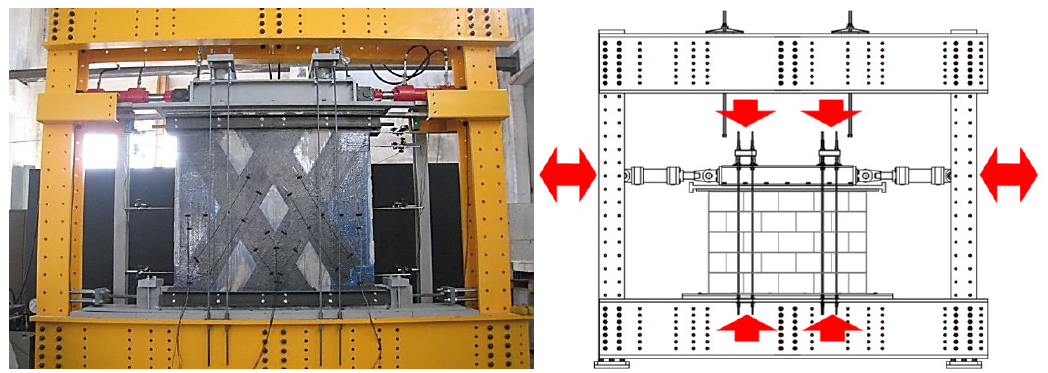
Figure 1. Set-up for static-cyclic shear load tests.